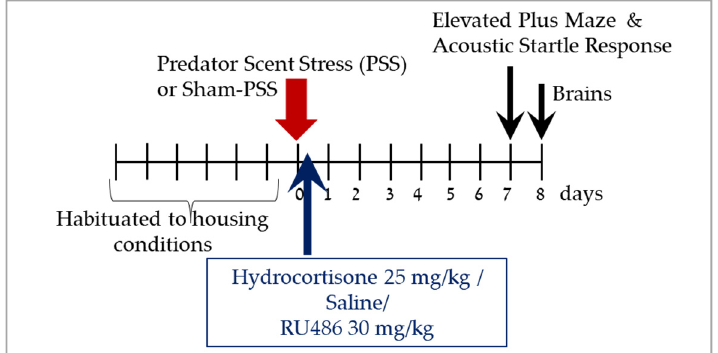
Figure 8. Study design—Effects of high-dose hydrocortisone, RU486 (GC receptor antagonist-mifepristone) or saline immediately post-exposure on behavioral stress responses at day 7 post-exposure. After habituation period of seven days, animals were exposure to PSS or sham-PSS for 15 min. Animals were exposed to predator scent stress (PSS), treated for 1 day with hydrocortisone 25 mg/kg, saline or RU486 30 mg/kg and assessed behaviorally with the elevated plus maze (EPM) and acoustic startle response (ASR) tests at day 7. On day 8, rats were sacrificed, and their brains were collected for immunoreactivity analyses of Iba-1 in the hippocampus subregions.